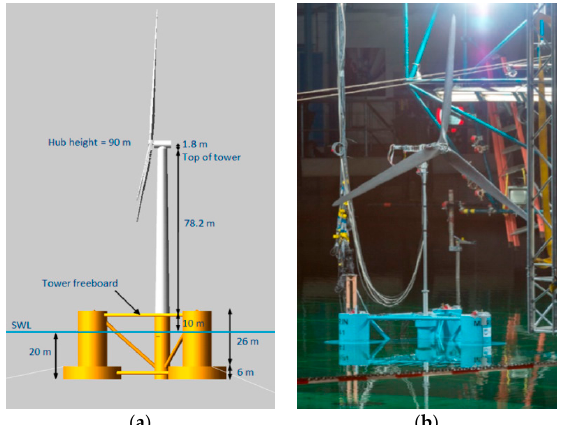
Figure 2. Semi-submersible model: ( a ) Full-scale model; ( b ) The 1/50th scale model in maritime research institute Netherlands (MARIN) wave basin.